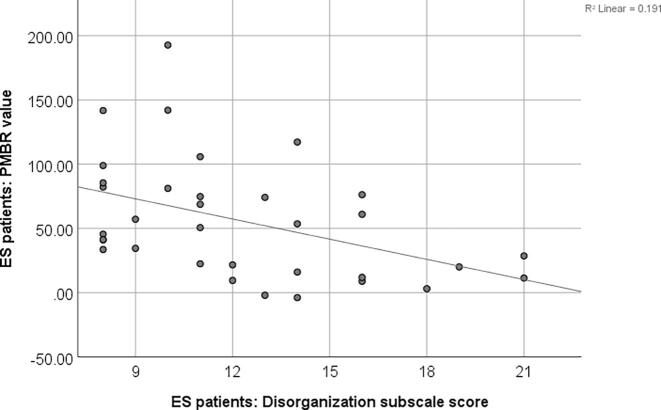
PMBR relationship with PANSS. The plot shows the disorganization PANSS subscale score factor correlated with the PMBR percentage change from baseline for the established patient group.